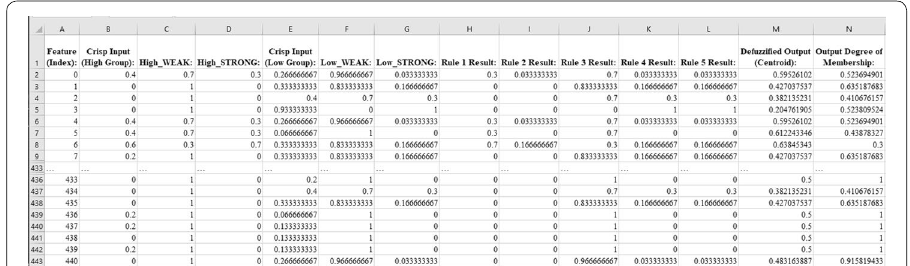
Fig. 8 FIS results for Robot Failure